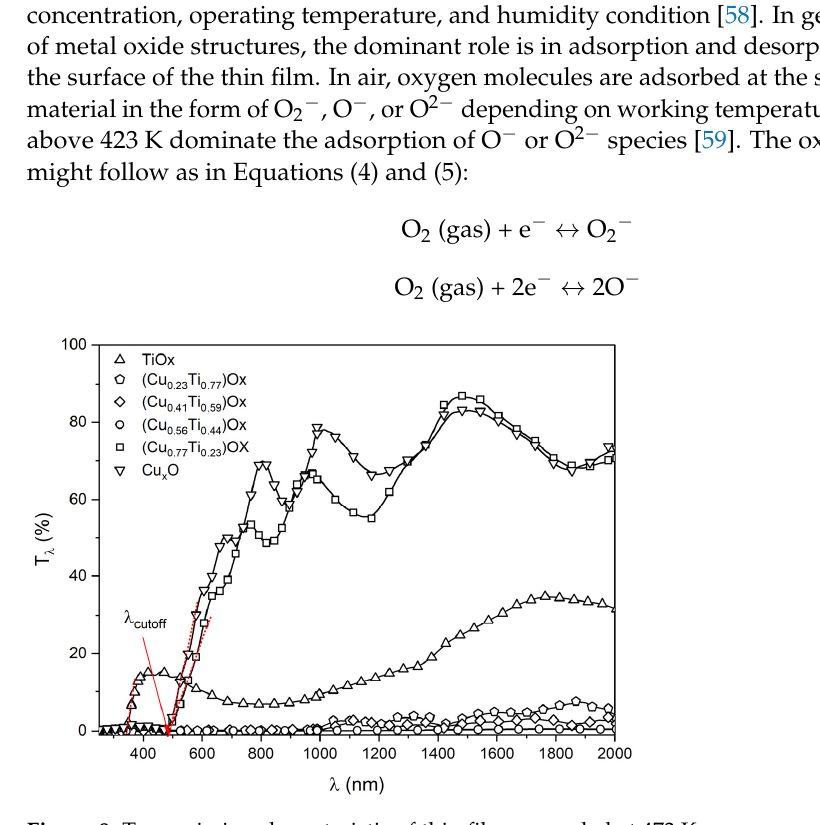
Figure 8. Transmission characteristic of thin films annealed at 473 K.